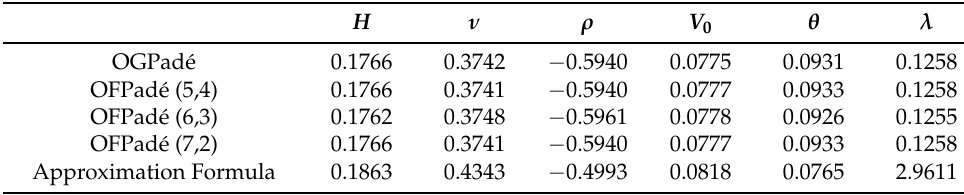
Table 3. Calibration to SPX implied volatility on 15 September